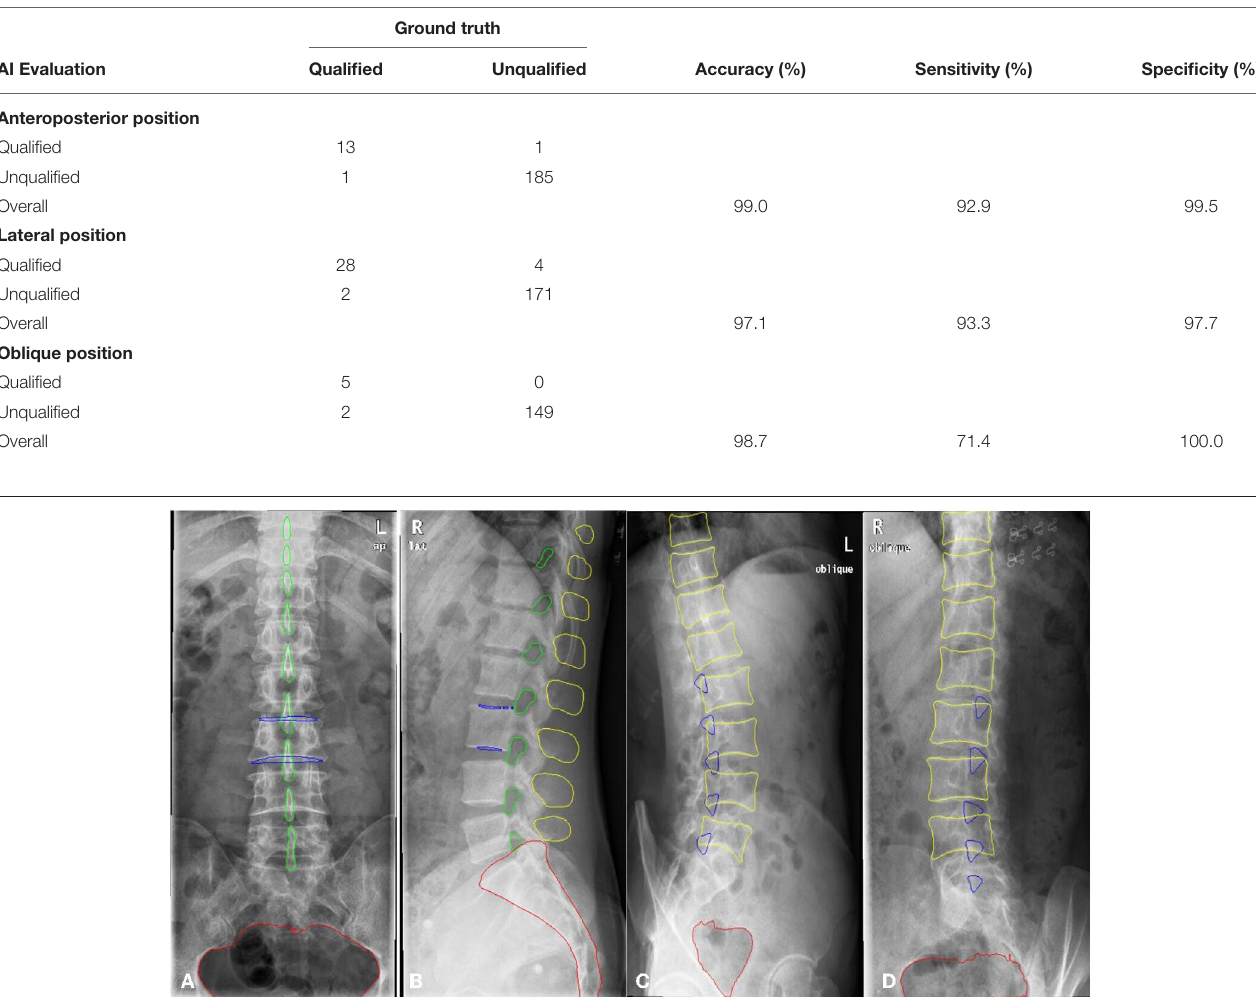
TABLE 3 | Results of the automatic assessment system on the validation set that including 319 patients (200, 205, and 156 images for anteroposterior, lateral, and oblique position, respectively). Ground